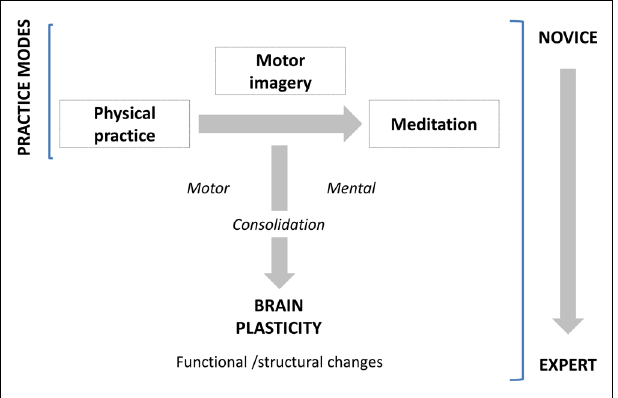
FIGURE 1 | Practice modes and consolidation processes leading to